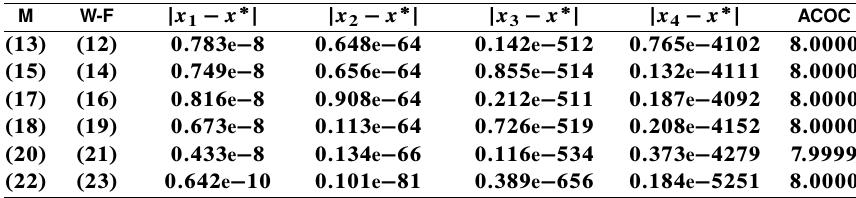
p / (cid:0) 5;x (cid:3) D 2;x 0 D 1:5 , for different methods (M) and weight functions (W-F). x 2